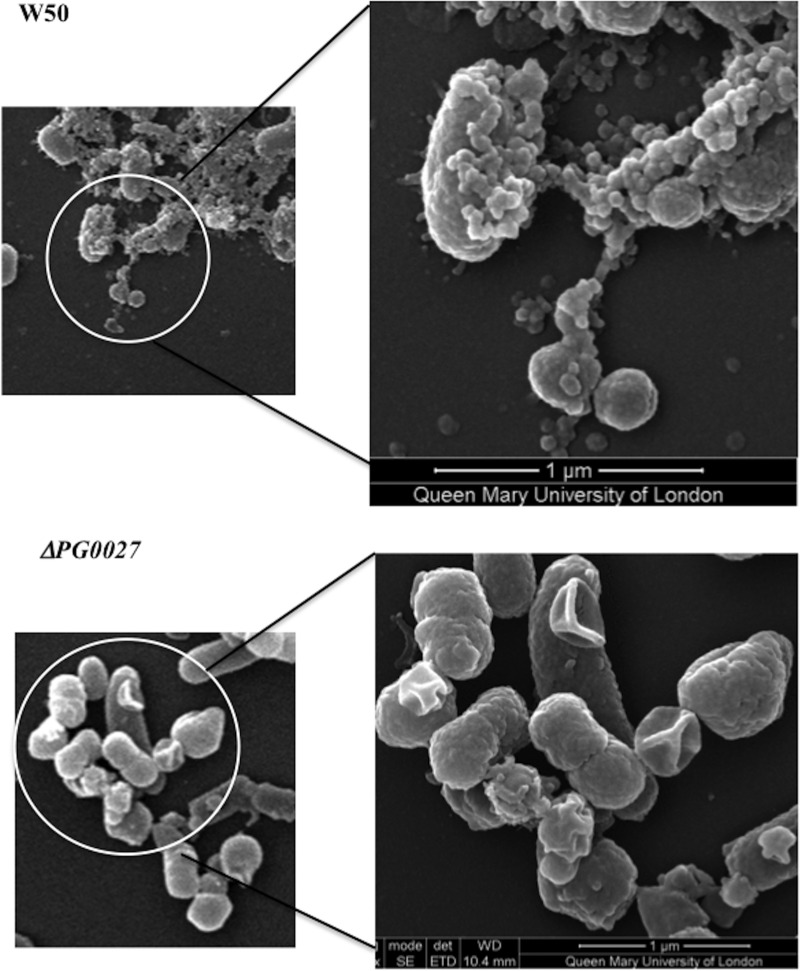
SEM of P. gingivalis W50 and the ΔPG0027 mutant strain. Samples were prepared for SEM as described in Materials and Methods. The scale bar represents 1 μm. P. gingivalis W50 shows the characteristic membrane blebbing forming OMVs, which is not present in the ΔPG0027 mutant strain.